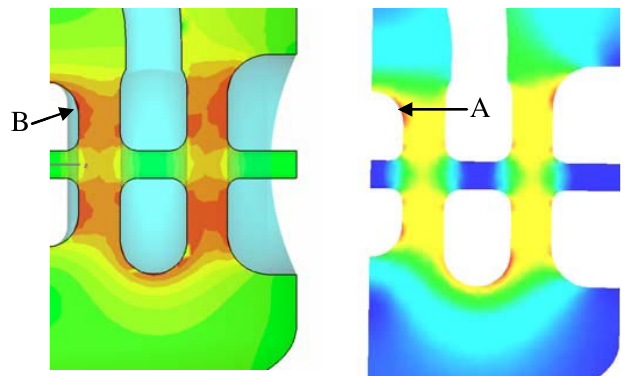
FIG. 5. (Color) Electric field contours in the (cid:8) y; z (cid:9) plane simu- lated with MWS with 2 (cid:10) 10 6 mesh points (on the left) and ANALYST with 1 : 6 (cid:10) 10 6 mesh elements (on the right).